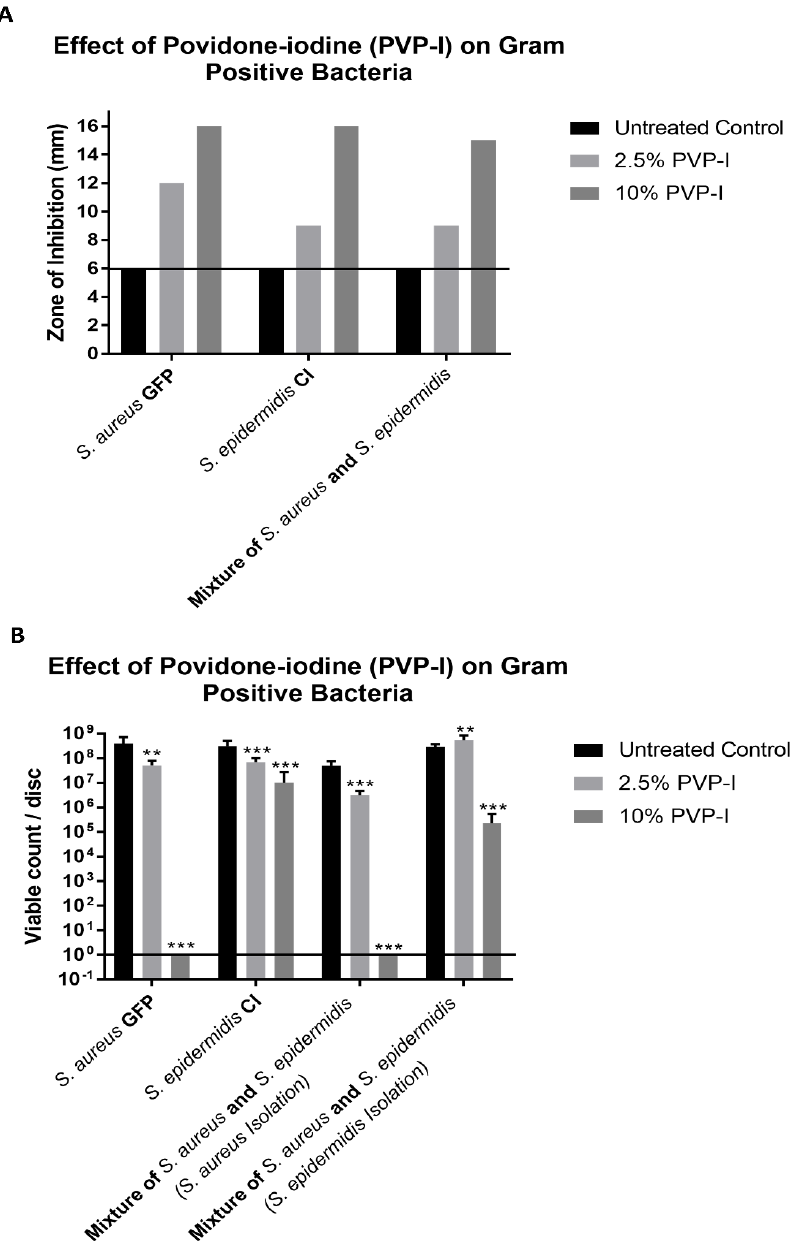
Figure 1. ( A ) The zones of inhibition (ZOI) of Gram-positive bacteria on the discs were measured in mm. ( B ) The bacteria remaining on the disc was quantified by the CFU assay. The different numbers of stars represent significance: ** p < 0.01, and *** p < 0.001. The 10% Betadine solution only showed the complete killing of S. aureus when grown individually and with S. epidermidis . S. epidermidis showed a lower viable count at 10% when grown with S. aureus , but still showed incomplete killing. P. aeruginosa showed no difference from the control trial viable count when grown individually and only a slightly lower count when grown with A. baumannii ; however, incomplete killing still occurred. A. baumannii showed a lower viable count when grown individually and with P. aeruginosa but did not show complete